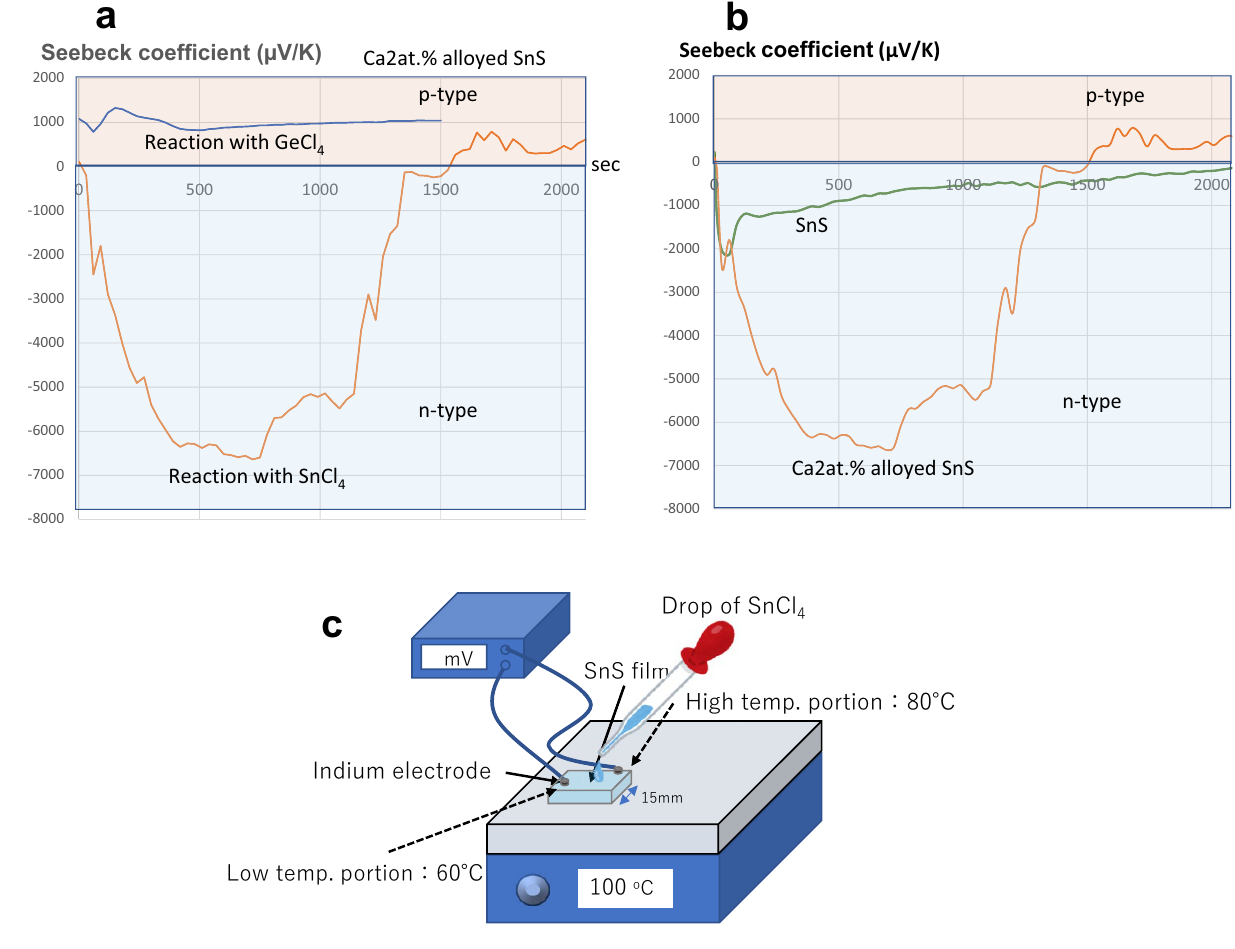
Figure 5. Time-dependent Seebeck effect measurement. ( a ) Results of time-dependent Seebeck effect measurements after liquid SnCl 4 or GeCl 4 were dropped on the Ca 2 at.% alloyed SnS film. ( b ) Comparison between alloyed Ca 2 at.% and pure SnS films in terms of time-dependent Seebeck effect measurements. ( c ) Schematic for the time-dependent Seebeck effect